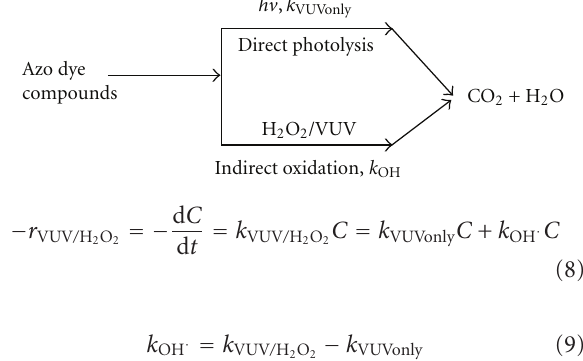
di ff erence between the rate constant of VUV/H 2 O 2 treatment ) and the rate constant of VUV system alone ( k VUV / H 2 O 2 ( k VUVonly ) ((8) and